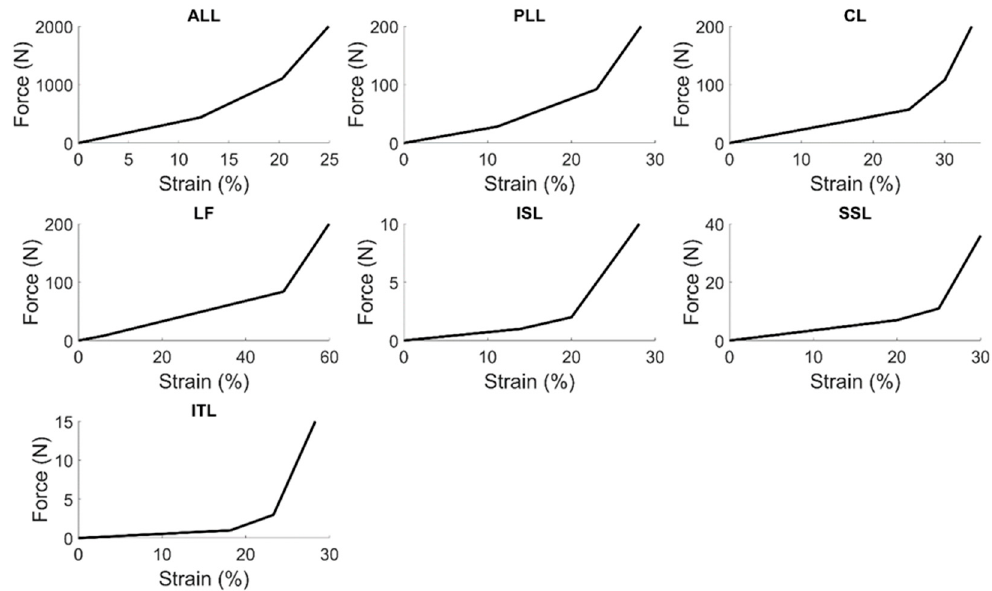
Figure A1. The nonlinear force-strain relationships of the seven spinal ligaments applied in the current study.